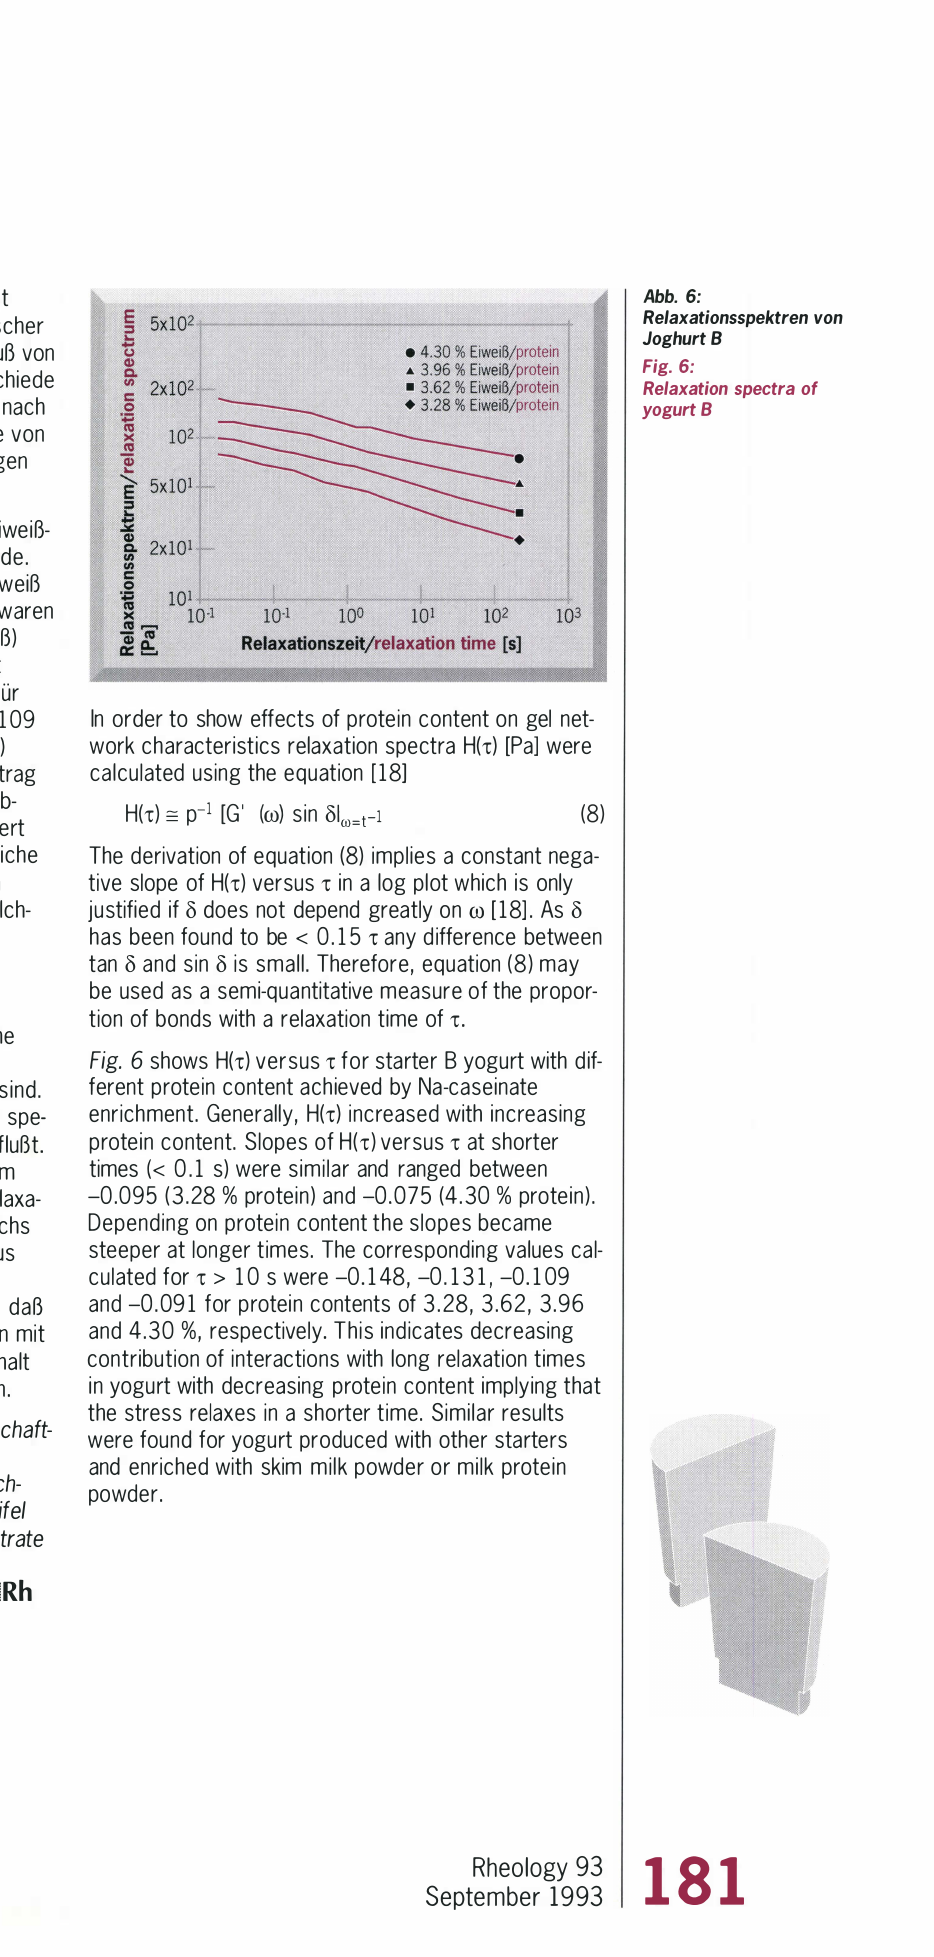
Fig. 6: Relaxation spectra of yogurt